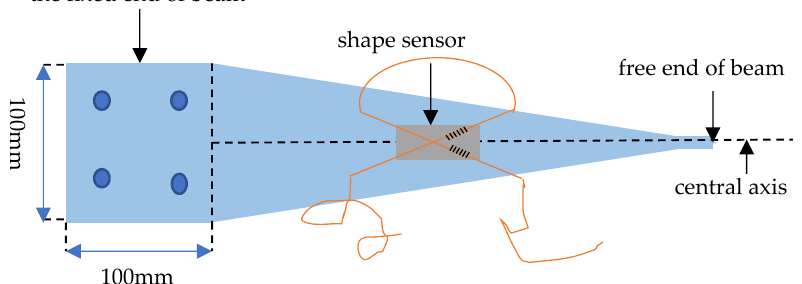
Figure 7. Simulation model of dual FBG high-precision shape sensor.